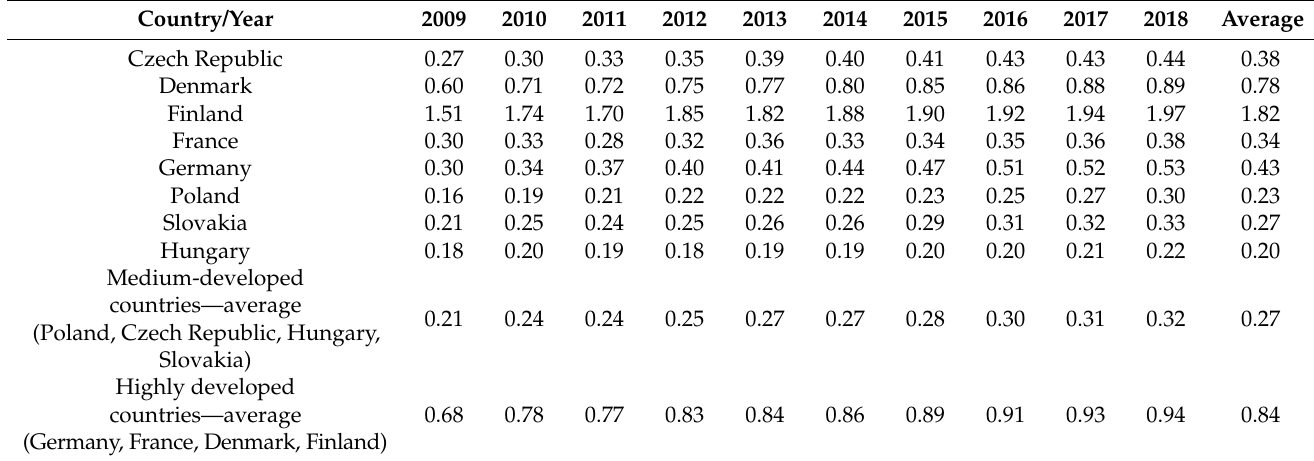
Table 3. Renewable energy consumption per capita in the surveyed EU countries (in TOE per 1000 inhabitants).